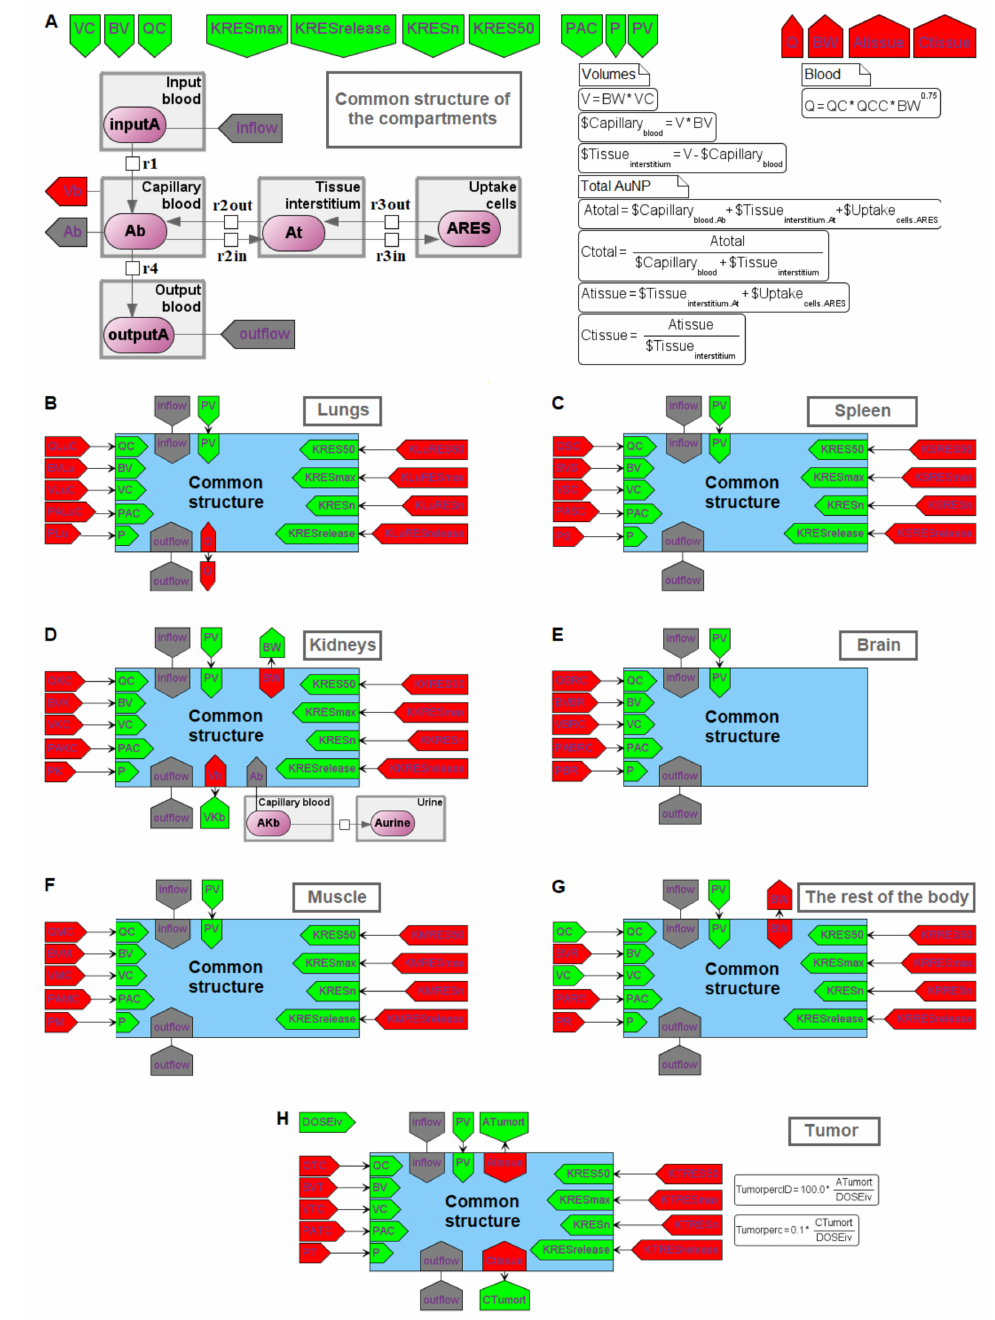
Figure 9. Determination of the PBPK model of nanoparticle delivery to solid tumors in mice based on the modular approach. ( A ) The common structure of the model compartments as a separate module in SBML format and SBGN notation. ( B – H ) Representation of similar modules in BioUML. The interpretation of the parameters is the same as in Table 1, corrected for the corresponding